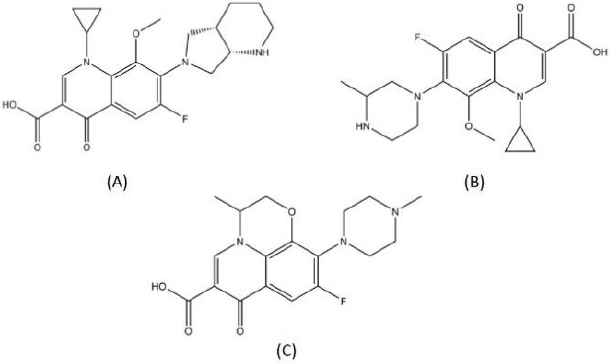
Figure 1. Structure of ( A ) moxifloxacin, ( B ) gatifloxacin, and ( C ) levofloxacin.